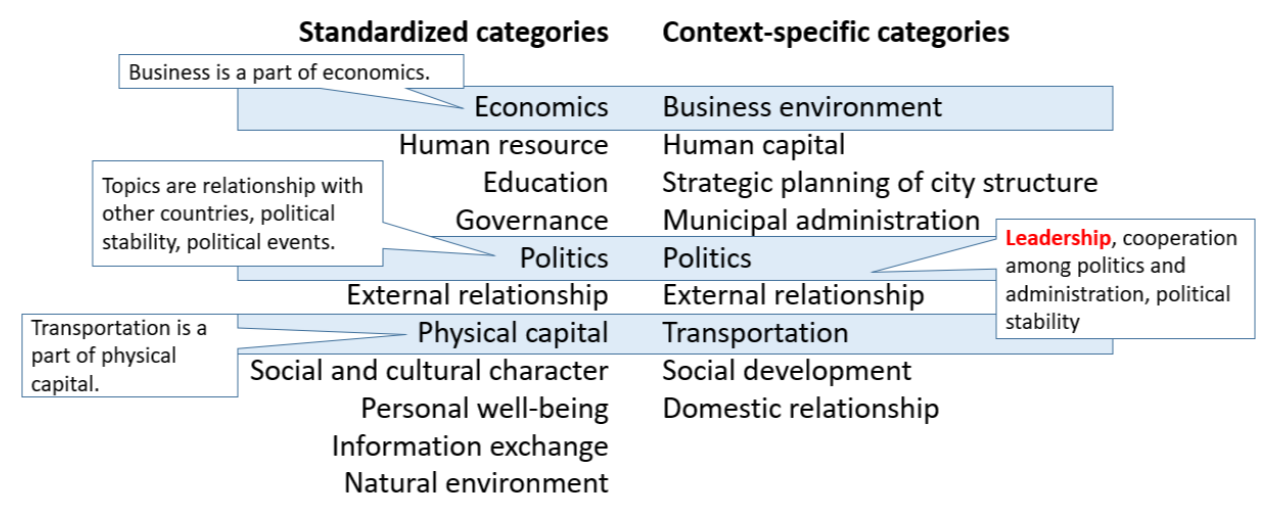
Figure 4. Overview of standardized categories for livable city evaluations versus context-specific categories in the case of Malm¨o (retrieved from Table 2 and Table 4, respectively), highlighting the authors’ choices of points for